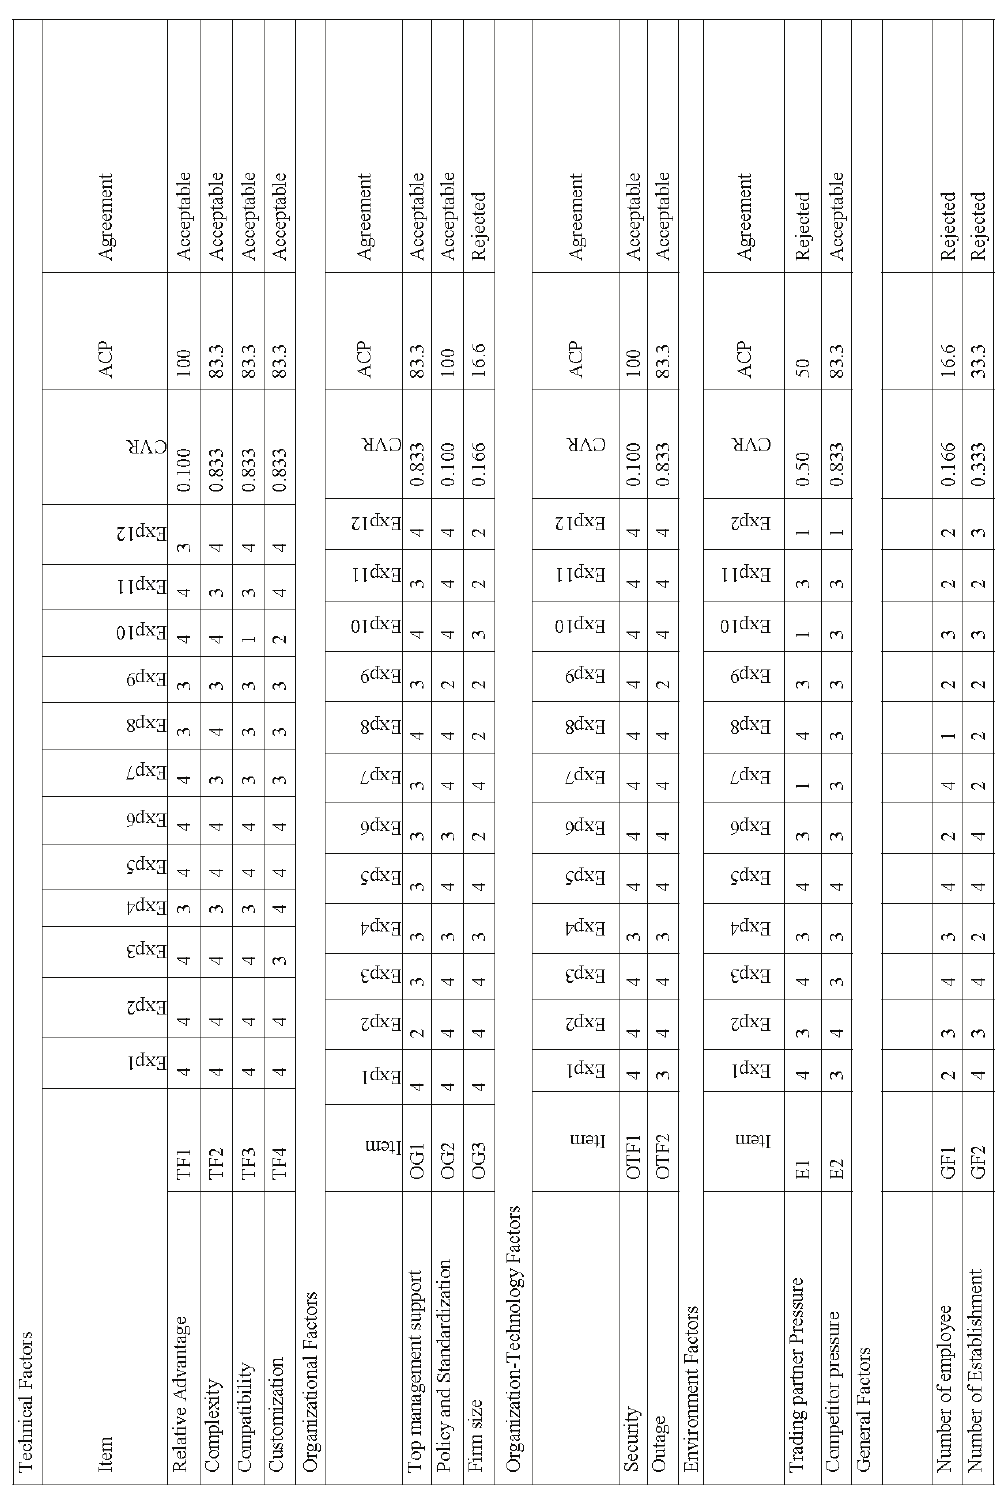
Table 1. Content Validity